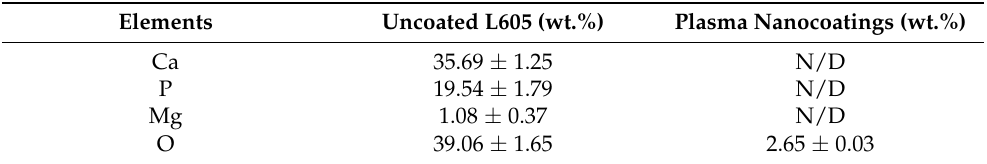
Table 3. EDS data of weight percentages (wt.%) of the adsorbed products on uncoated and plasma- nanocoated coupon surfaces after immersion test, n = 3. N/D: None detected. Elements Uncoated L605 (wt.%) Plasma Nanocoatings